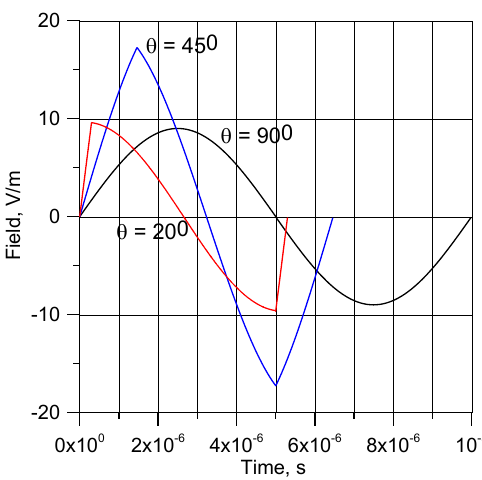
Figure 4. Electric radiation field for r = 100 km for three values of angle θ . The angle θ and distance r are defined in Figure 3. The peak current associated with the pulse, I 0 , is equal to 30 kA.